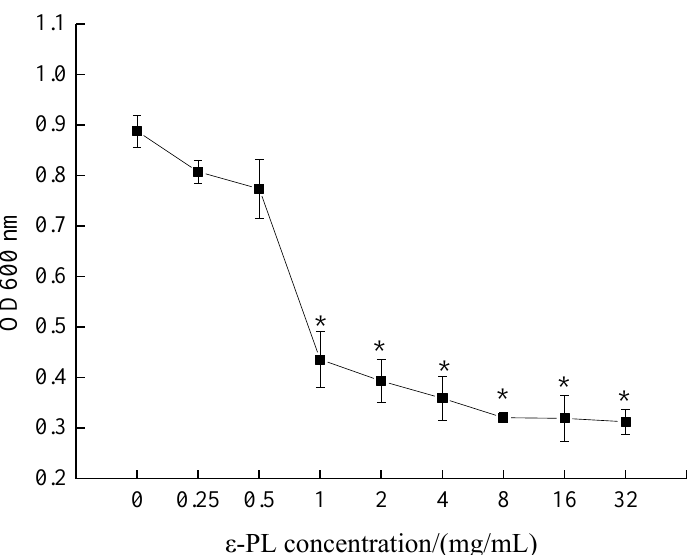
Figure 1. Minimal inhibitory concentration (MIC) of ε-polylysine (ε-PL) against S. putrefaciens. Bars represent the standard error of the means. The superscript (*) indicates a result that is significantly different to the equivalent control point (t test, p < 0.05 ).